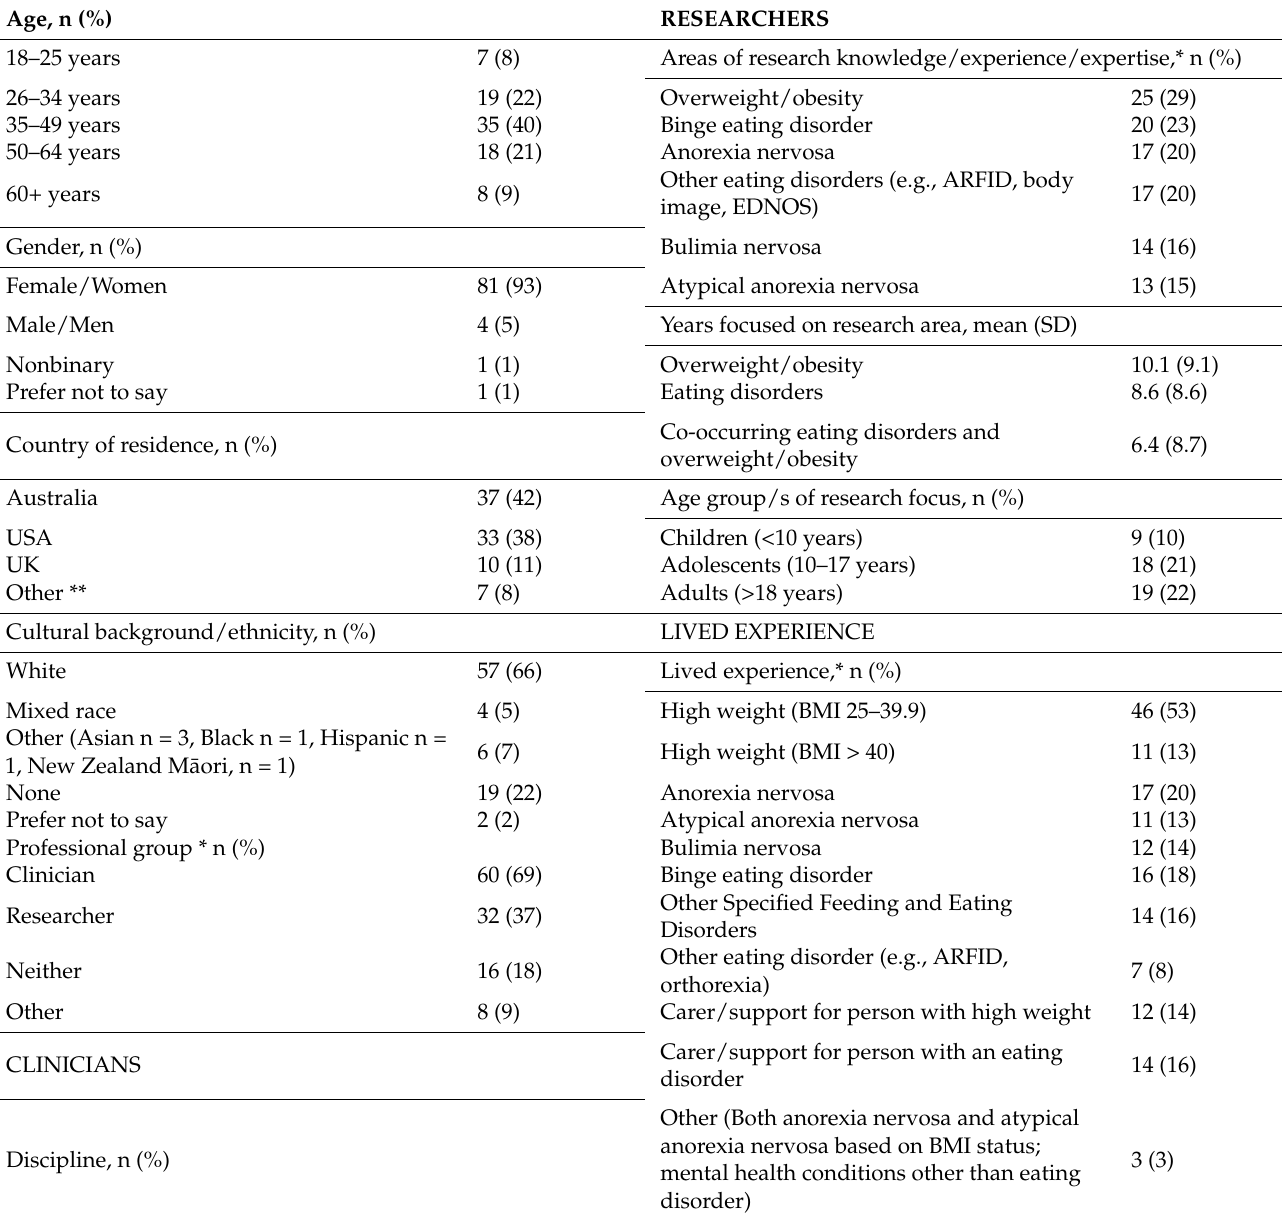
Table 1. Participant characteristics, n =